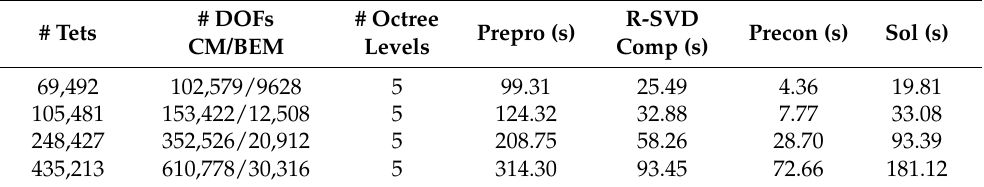
Table 8. Computation times for the CM-BEM software with R-SVD compression (prepro: preprocessing,